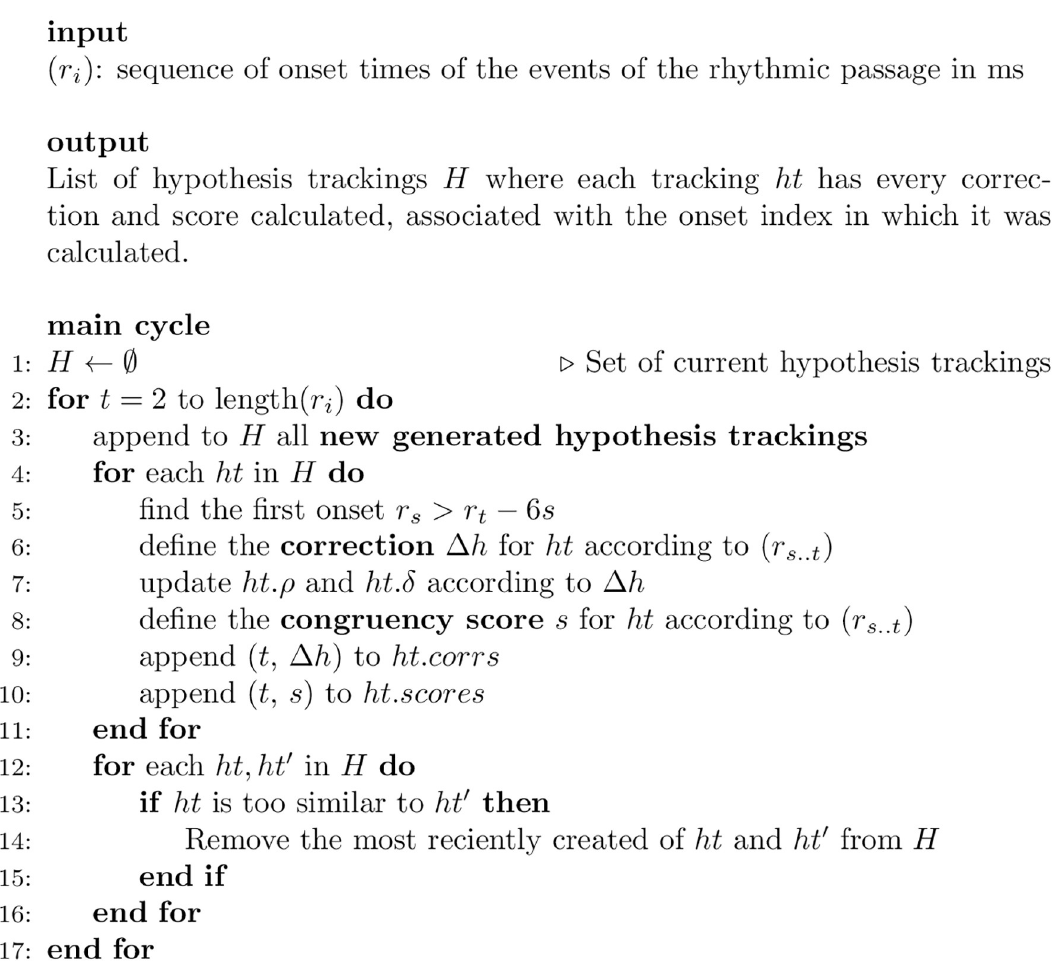
Fig 4. Description of the model’s main